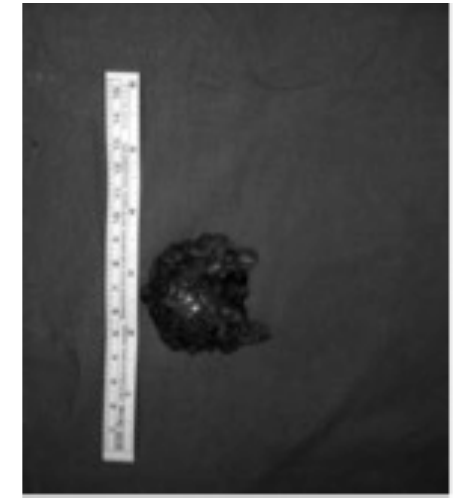
Figure 5: Specimen